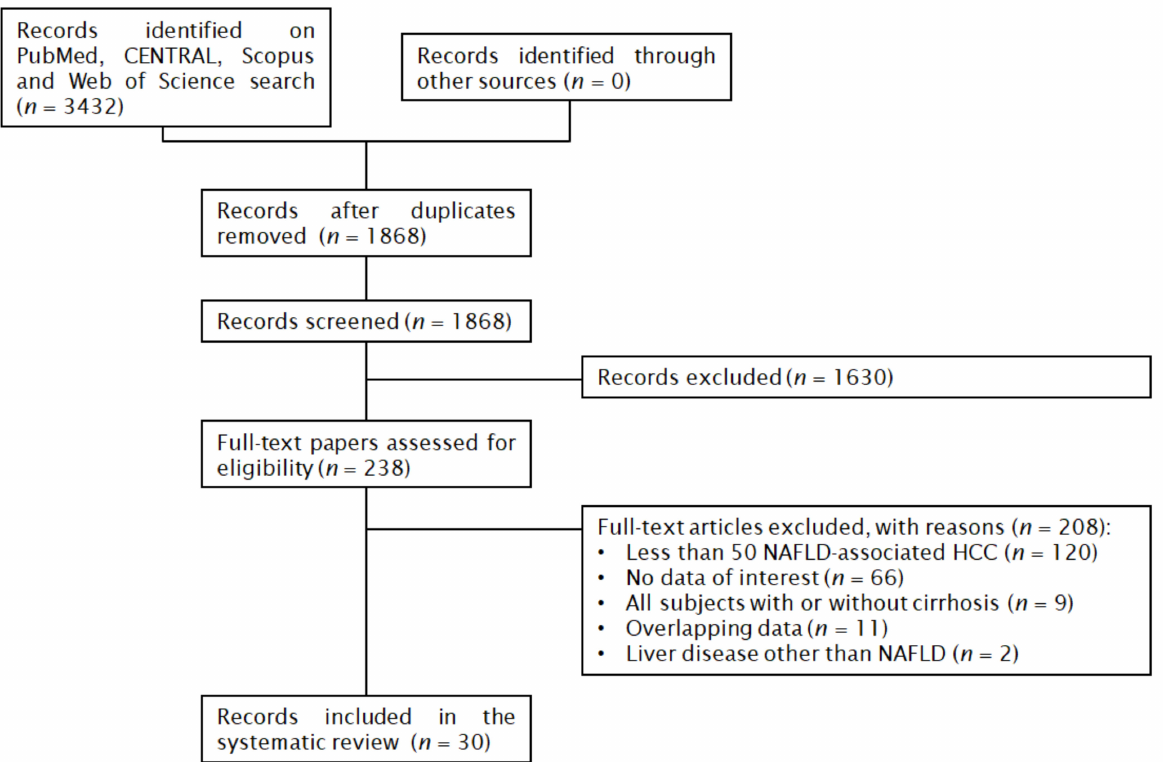
Figure 1. Flow chart of the systematic